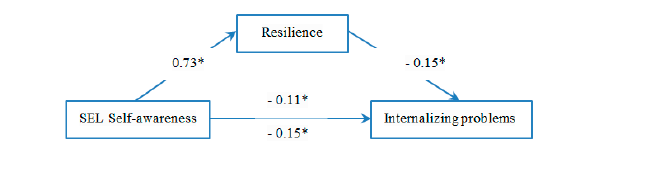
Figure 1. Mediating effects of resilience between SEL dimensions and internalizing problems.